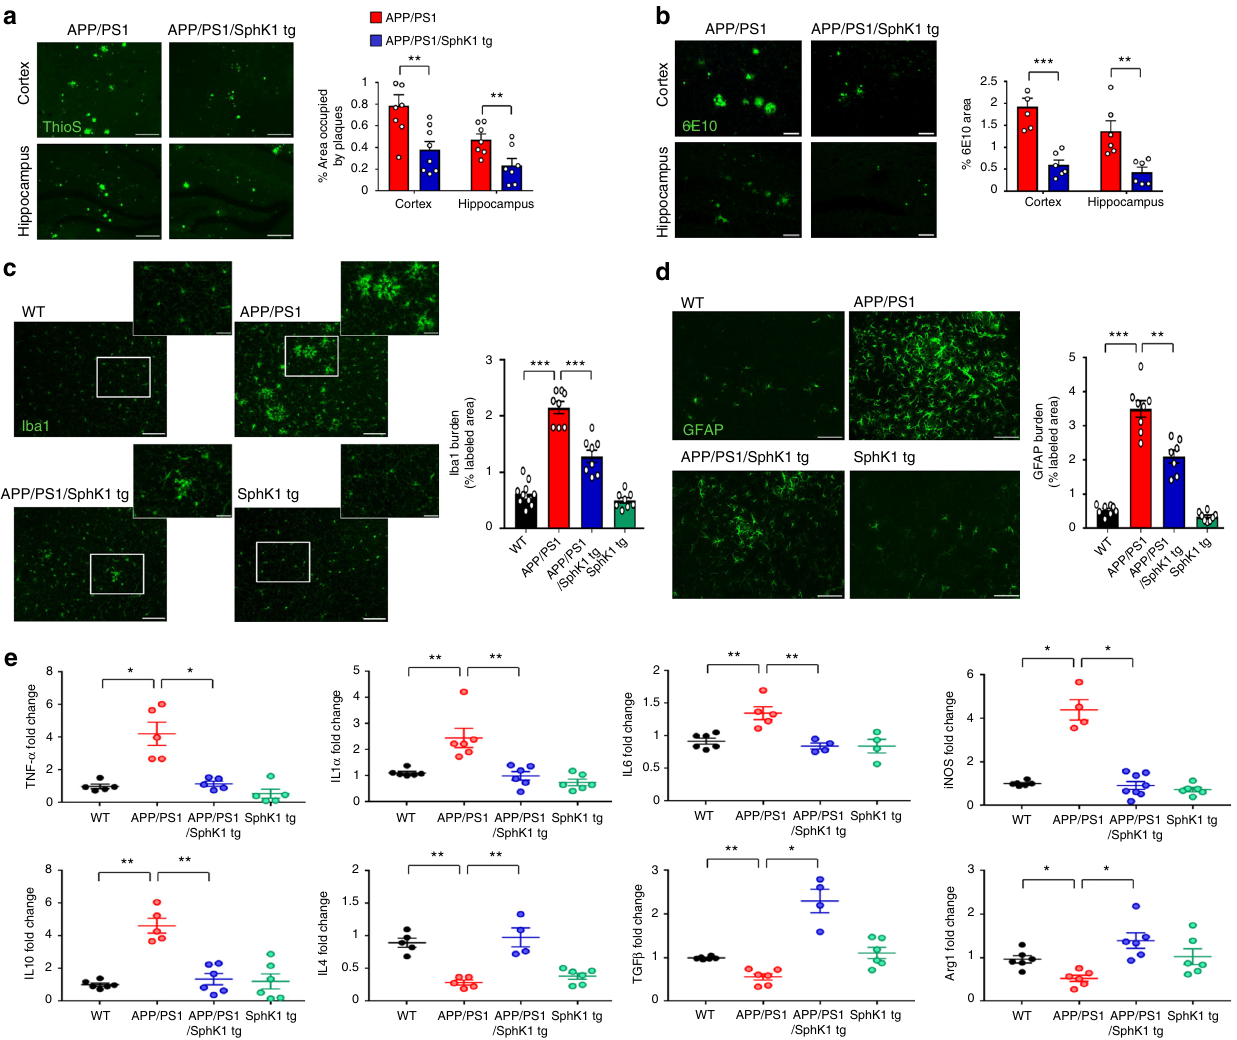
Fig. 2 Elevation of SphK1 reduces A β deposition and neuroin fl ammation in APP/PS1 mice. a Left, representative immuno fl uorescence images of thio fl avin S (ThioS, A β plaques) in cortex and hippocampus of APP/PS1 and APP/PS1/SphK1 tg mice. Scale bars, 200 μ m. Right, quanti fi cation of area occupied by A β plaques ( n = 7 – 8 per group). b Representative immuno fl uorescence images and quanti fi cation of 6E10 ( n = 5 – 6 per group; Scale bars, 80 μ m). c Left, immuno fl uorescence images of microglia (Iba1) in cortex of WT, APP/PS1, APP/PS1/SphK1 tg or SphK1 tg mice brain. Low-magni fi cation scale bars, 100 μ m; High-magni fi cation scale bars, 30 μ m. Right, quanti fi cation of microglia ( n = 8 – 10 per group). d Left, immuno fl uorescence images of astrocyte (GFAP) in cortex of mice brain. Scale bars, 100 μ m. Right, quanti fi cation of astrocytes ( n = 7 – 8 per group). e mRNA levels of in fl ammatory markers in cortex of mice brain ( n = 4 – 8 per group). Pro-in fl ammatory marker: TNF- α , IL-1 β , IL-6 and iNOS , Immunoregulatory cytokine: IL-10 , Anti-in fl ammatory marker: IL-4, TGF- β and Arg1 . All data analysis was performed on 9-month-old mice. a , b Student ’ s t test. c – e One-way analysis of variance, Tukey ’ s post hoc test. * P < 0.05, ** P < 0.01, *** P < 0.001. All error bars indicate expression is regulated through PI3K, AKT and mTOR 12 signaling, and the enzyme activity of SphK1 is modulated by ERK1/2-mediated